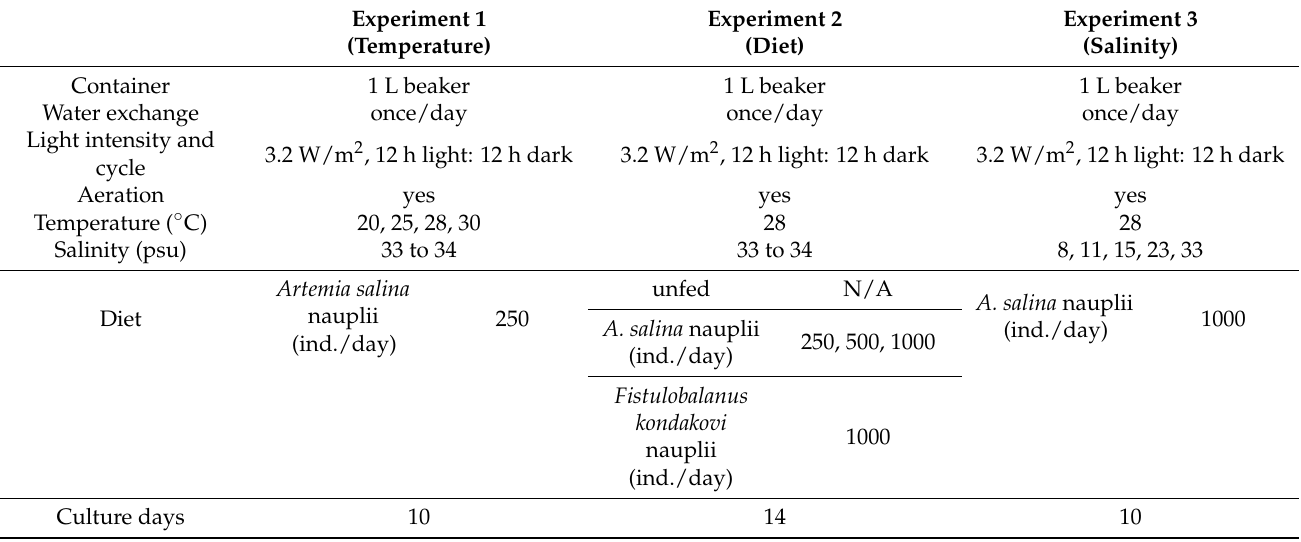
Table 1. Culture conditions of A. minuta under different temperatures, diet, and salinity